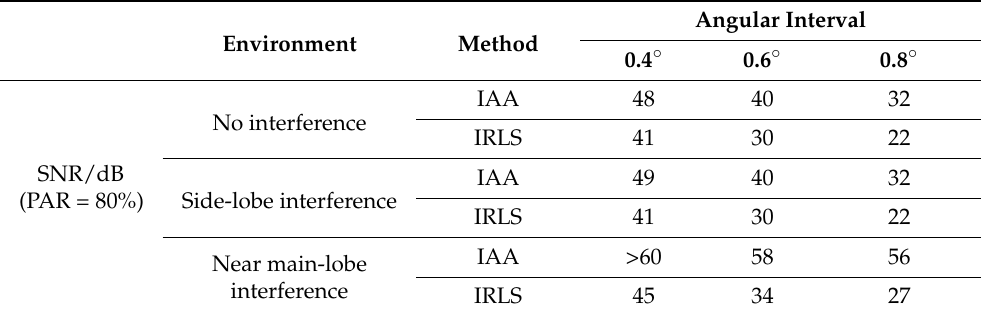
Table 4. The needed SNRs of IAA and IRLS Table 4. the needed SNRs of IAA and IRLS methods.